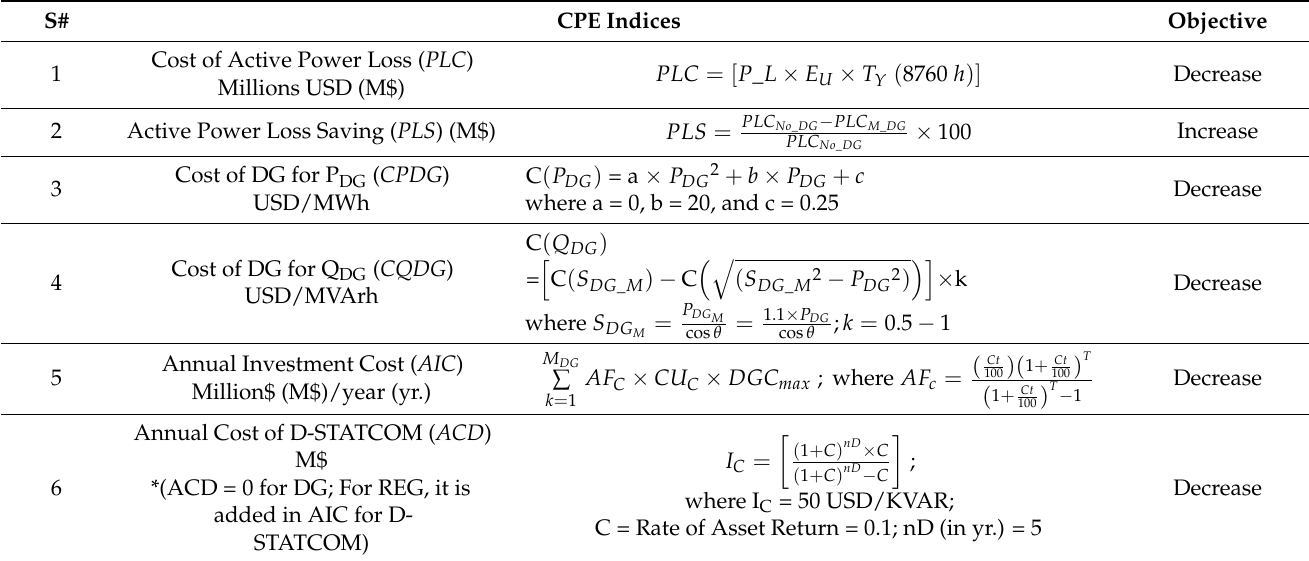
Table 4. Cost-economic performance evaluation (CPE) indices